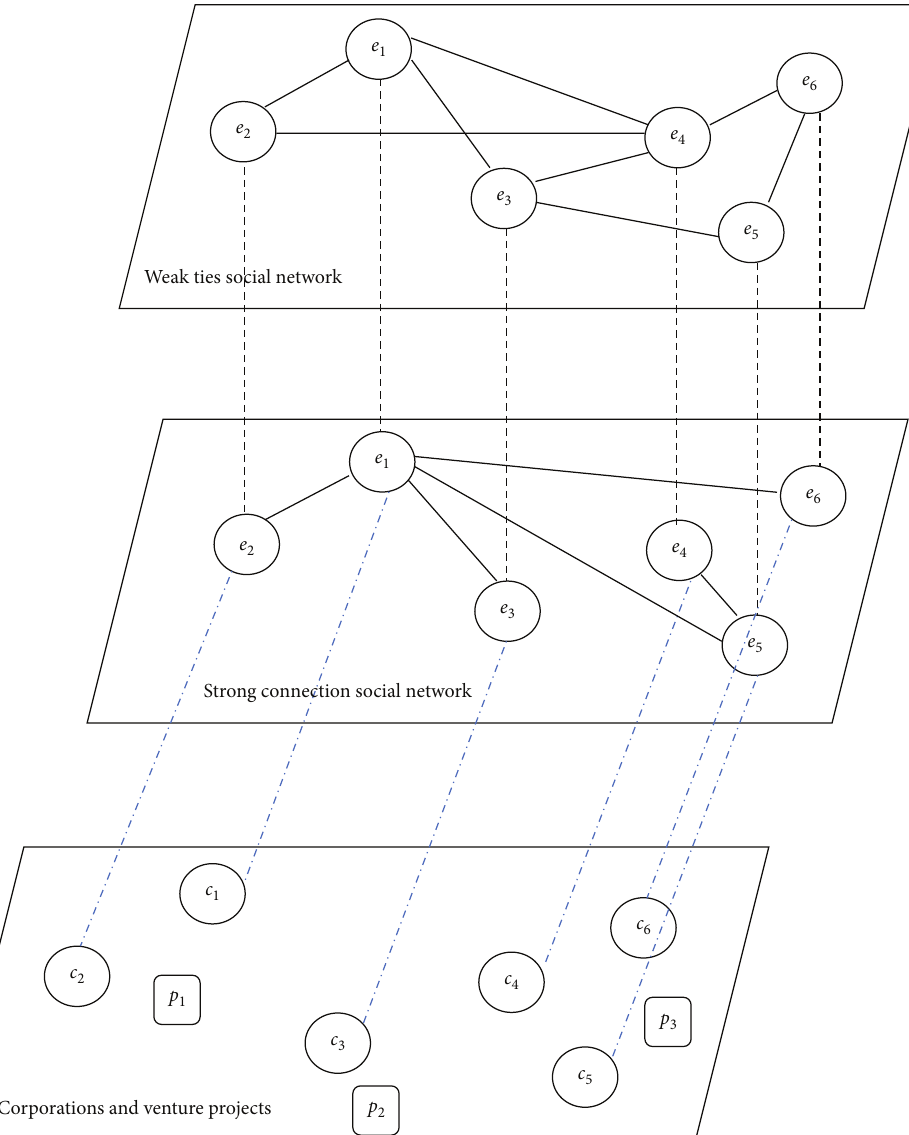
Figure 1: Corporations, venture projects, and social network of